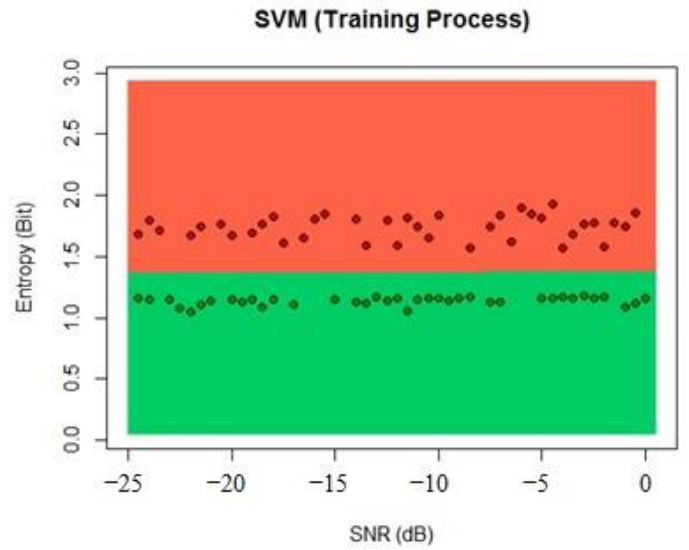
Figure 11. SVM training process classification.